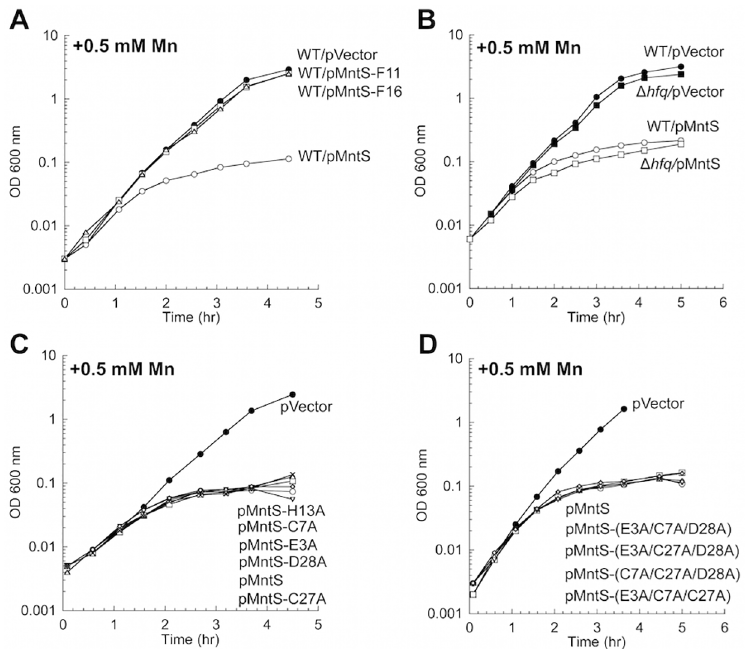
Fig 9. MntS confers manganese sensitivity by acting as a protein but not as a metal chaperone. Cells were cultured in aerobic LB/arabinose supplemented with 0.5 mM MnCl 2 2.5 hr before harvesting. Data represent the mean of three independent cultures. A. Growth of WT (MG1655) cells expressing plasmids pVector (pBAD24), pMntS (pLW112, mntS driven by the araBAD promoter), pMntS-F11 (pJEM67, mntS containing a frameshift at F11), or pMntS-F16 (pJEM68, mntS containing a framshift at F16). ver time of Data represent the mean of three independent cultures. re JEM (s were harvested 2.5 hr mino acids meB. Growth of WT (MG1655) and Δ hfq (JEM1407) mutants. C. Growth of WT (MG1655) expressing plasmids with mutations in potential metal-binding residues: pMntS-E3A (pMS017), pMntS-C7A (pMS018),